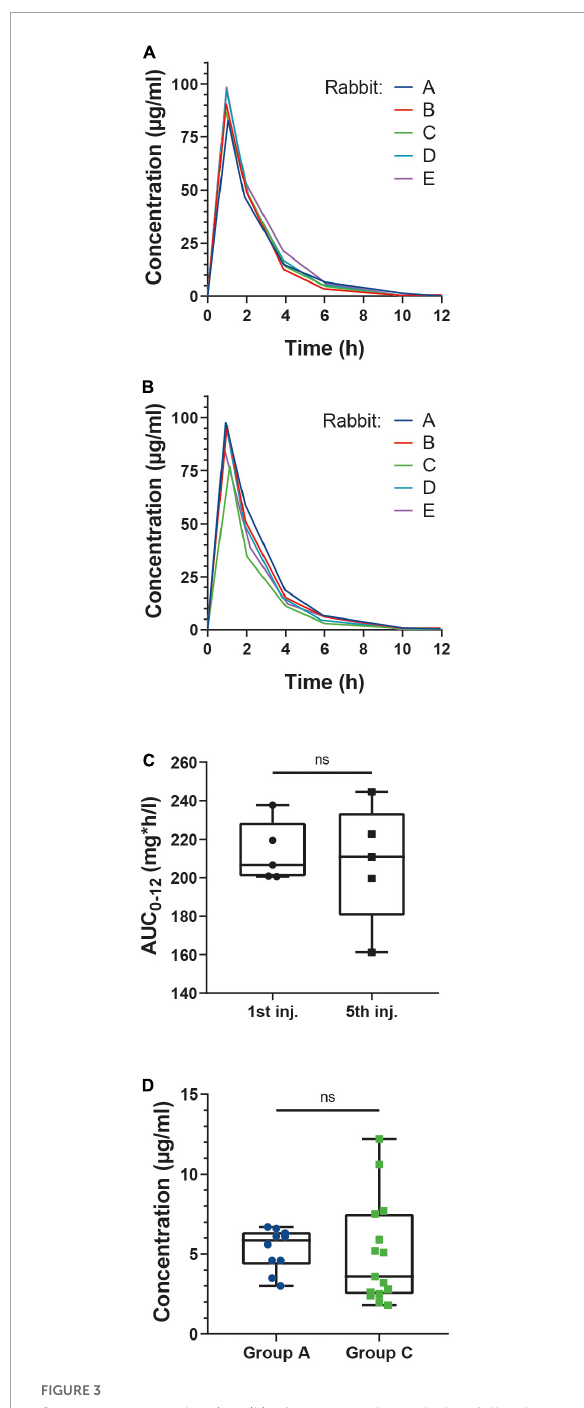
FIGURE3 Serum concentration (mg/L) of vancomycin evolution following the first (A) and fifth (B) injections in group A rabbits. (C) Box plots of the AUC 0 - 12 h after the first (left) and fifth (right) injections. AUC 0 - 12 h were computed using the trapezoidal method. AUC 0 - 12 h were compared with the Wilcoxon test. N = 5. (D) Box plots of the serum concentrations of vancomycin 6 h after injection in groups A and C. Concentrations were compared with the Welch corrected t -test following normality evaluation using the Kolmogorov Smirnov test. N = 10 (group A), 15 (groups